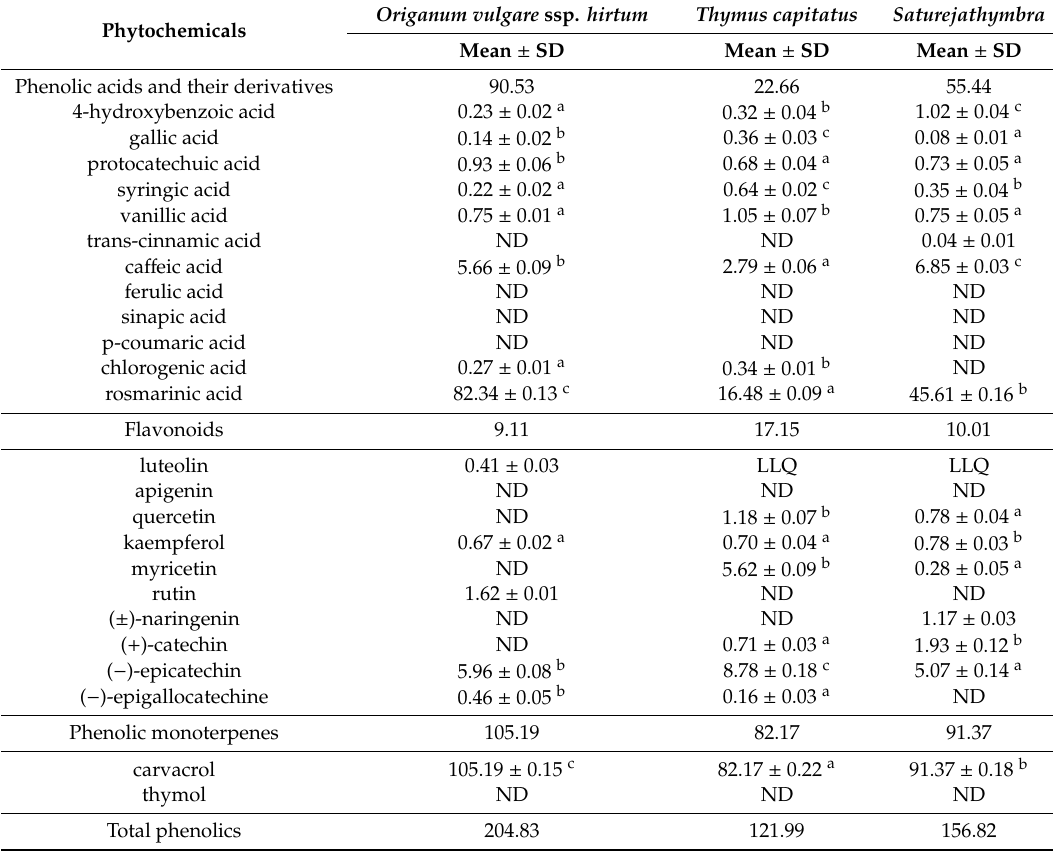
Table 2. Content ( µ g / mL) of phenolic compounds in aqueous solutions containing 1% dry matter of three aromatic plants autoclaved for 20 min at 121 ◦ C